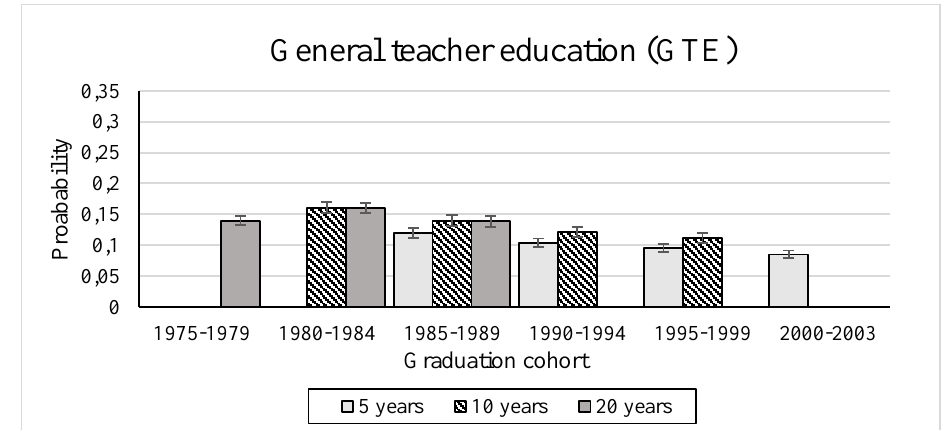
Figure 3. Predicted probability that General teacher education (GTE) gradu- ates are not employed in the school sector, by graduation cohort, at 5, 10, and 20 years after graduation. 95% CI error